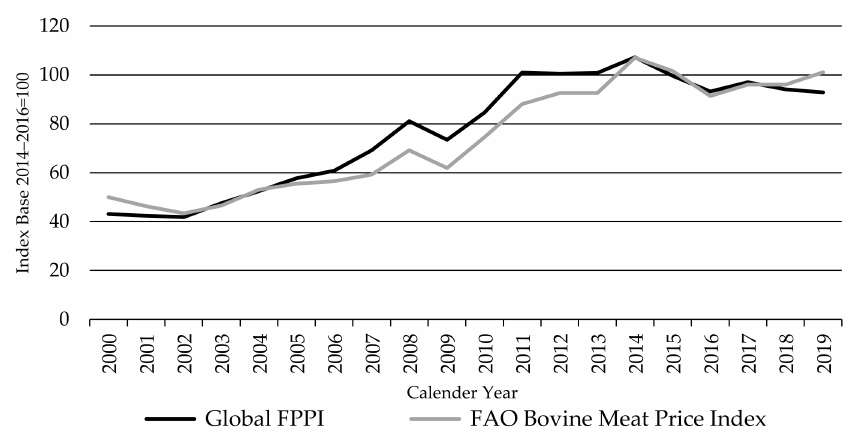
Figure 15. The Global Finished Cattle Producer Price Index FPPI and the FAO Bovine Meat Price Index, source: own illustration, FAO index